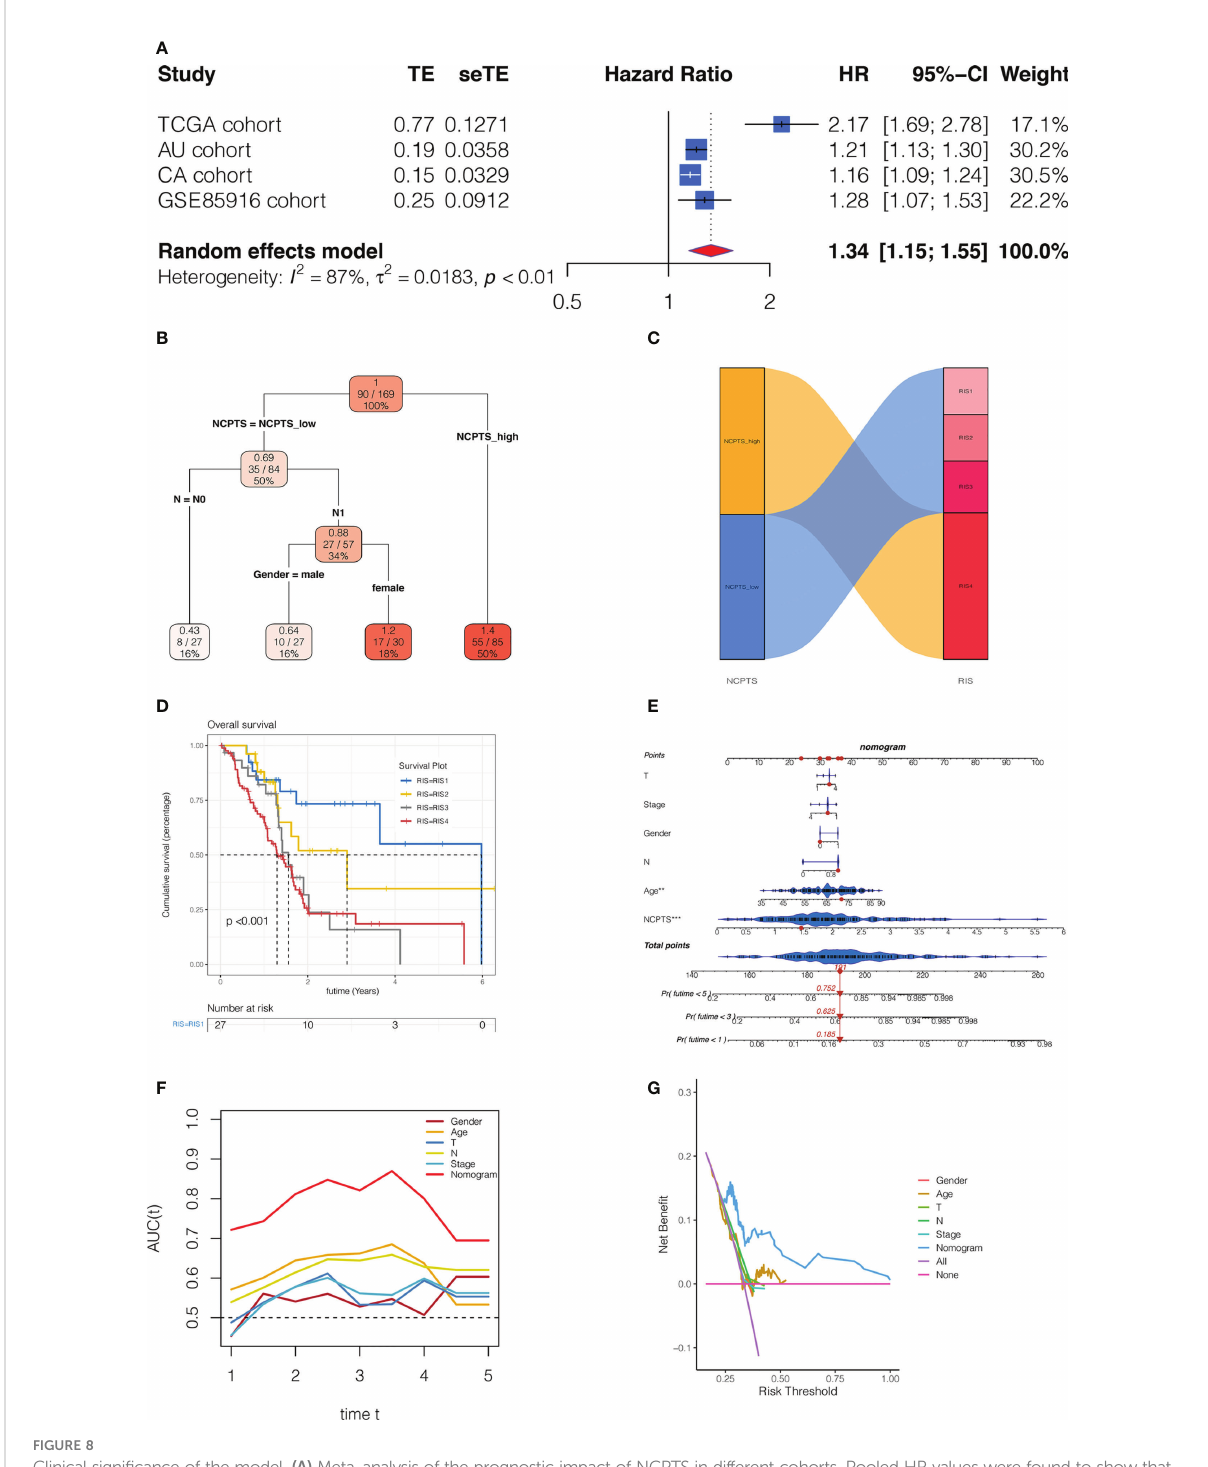
FIGURE 8 Clinical signi fi cance of the model. (A) Meta-analysis of the prognostic impact of NCPTS in different cohorts. Pooled HR values were found to show that NCPTS remained a contributing factor to poor patient outcome. (B) Decision tree analysis. Patients can be divided into 4 risk groups RIS1, RIS2, RIS3 and RIS4 according to the level of NCPTS, gender and N stage. (C) RIS4 patients were all distributed in the NCPTS_high group, while RIS1, RIS2, and RIS3 were distributed in the NCPTS_low group. (D) Survival analysis found that the RIS4 group had a poor prognosis (P <0.001). (E) Construction of the nomogram. Prognostic (F) The AUC predicted by Nomogram for patient prognosis remains around 0.8, which is signi fi cantly higher than other clinical features. (G) The bene fi t rate of patients receiving timely clinical treatment based on Nomogram is higher than other clinical